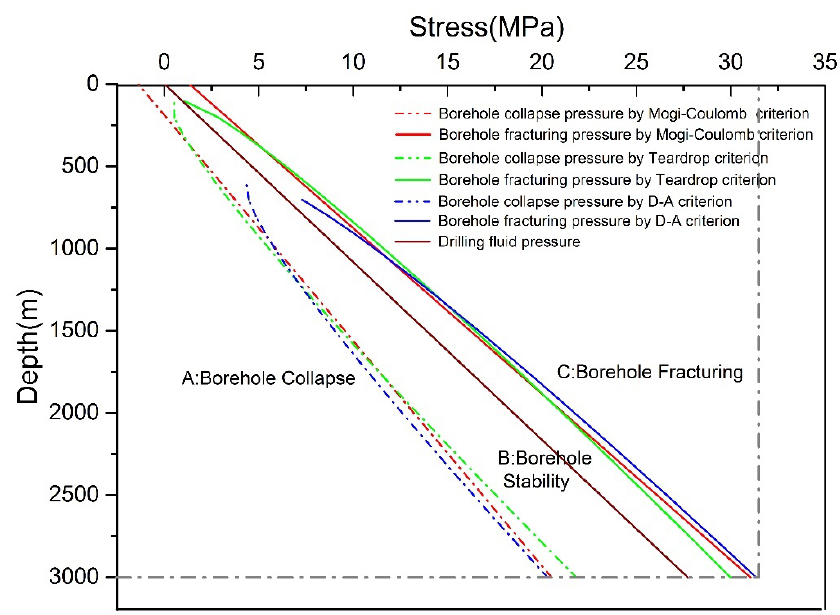
Figure 4. Critical borehole fracturing and collapse pressure considering the three failure criteria.